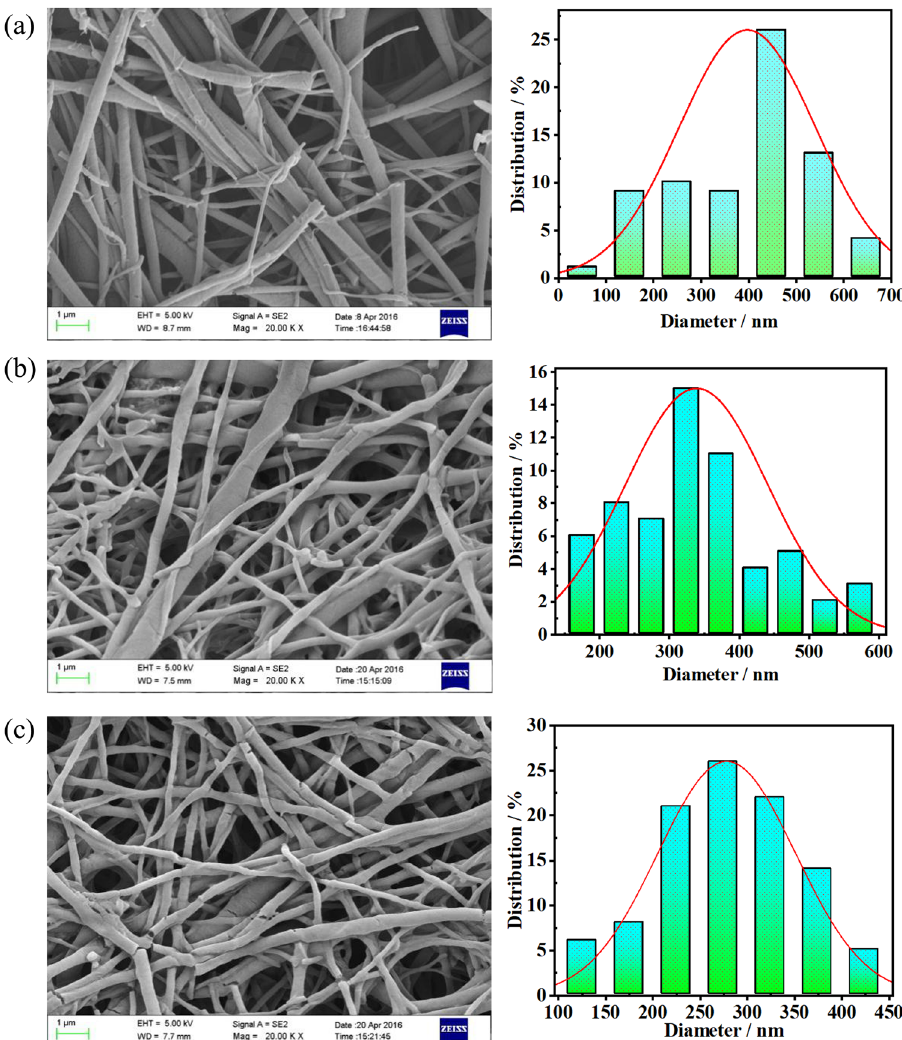
Figure 7: Morphology of the P ( 3HB - co - 4HB ) nano fi bers and diameter distribution with di ff erent blend ratios: ( a ) PVA/P ( 3HB - co - 4HB ) ( PVA 70 wt% ) , ( b ) PVA/P ( 3HB - co - 4HB ) ( PVA 80 wt% ) , and ( c ) PVA/P ( 3HB - co - 4HB ) ( PVA 90 wt% )